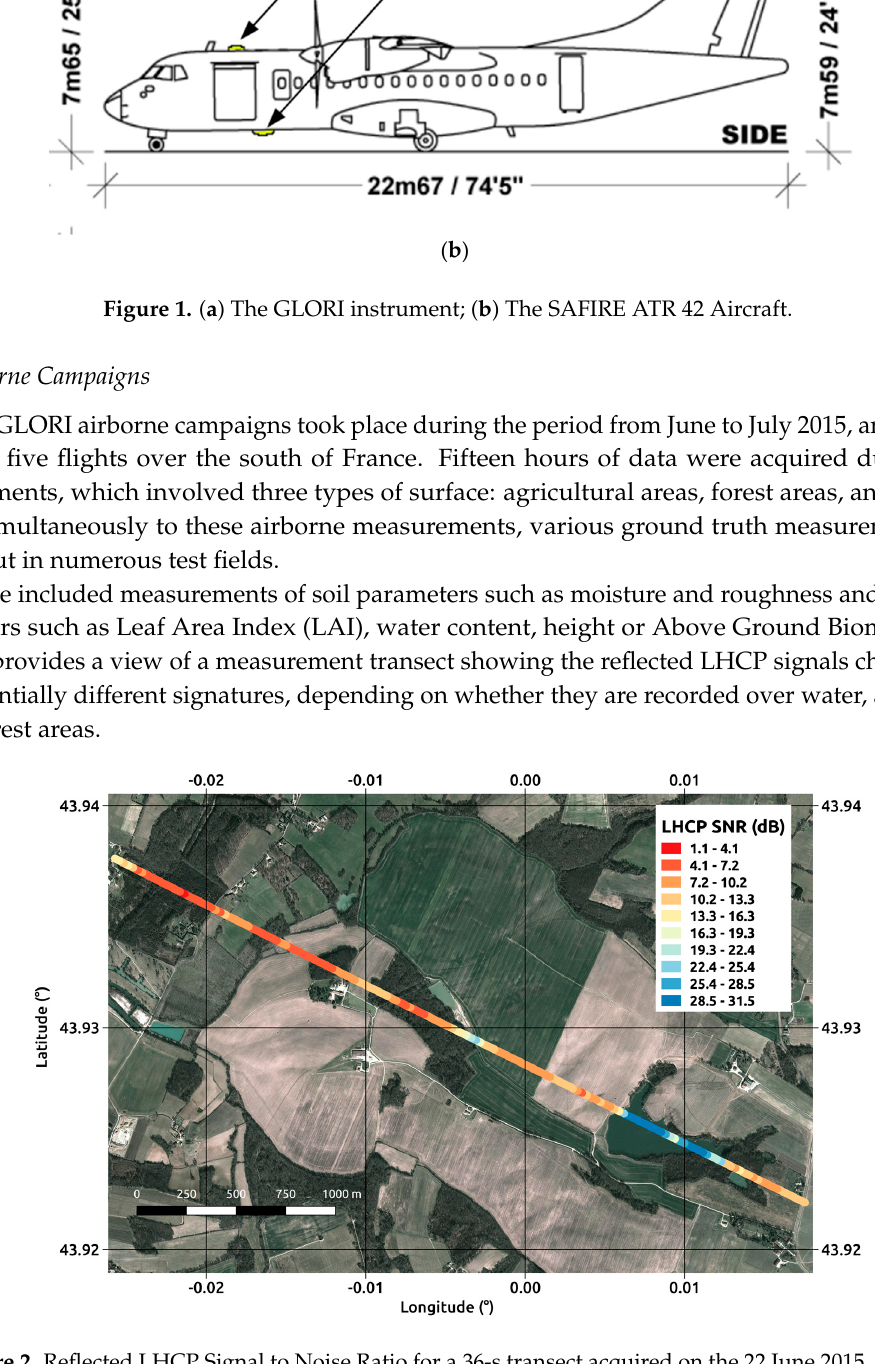
Figure 2. Reflected LHCP Signal to Noise Ratio for a 36-s transect acquired on the 22 June 2015. PRN23, Elevation angle 78°. The aircraft altitude is ~2000 m AGL, and the measurement temporal resolution (incoherent averaging time) is 240 ms.